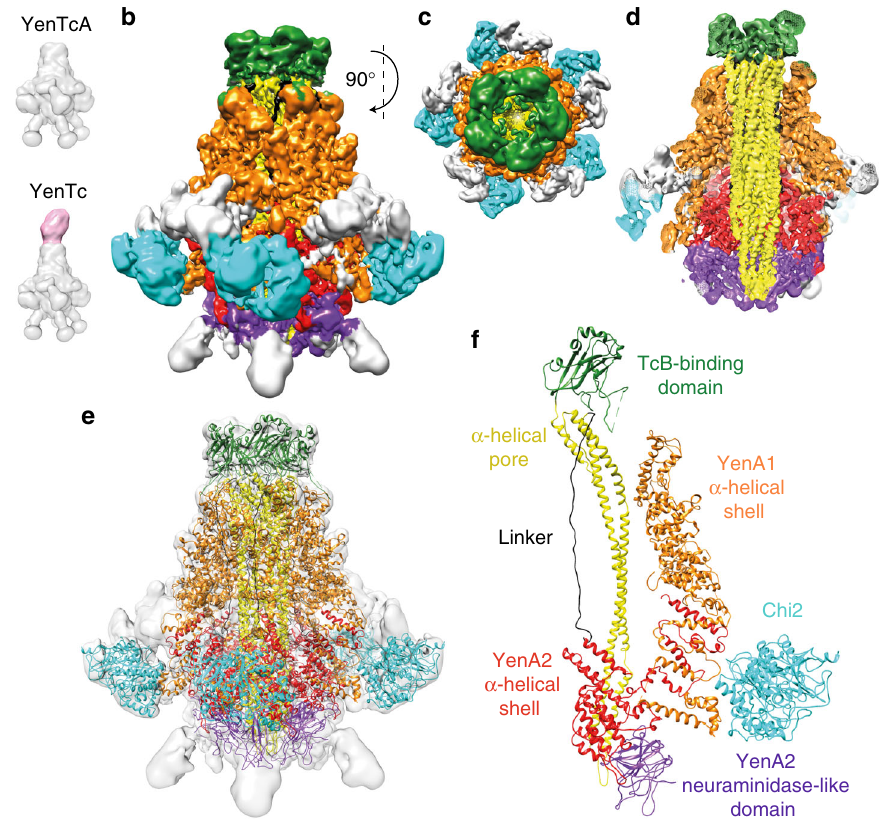
Fig. 1 The structure of YenTcA at 4.4 Å resolution. a Schematic representing the structure of YenTcA in the context of the holotoxin, YenTc. b , c 3D Cryo- EM map of the pentameric YenTcA in the soluble (pre-pore) conformation as side and top view orientations. d A cut-away view of the map revealing the encapsulated translocation pore. The map ( b – d ) is fi ltered according to local resolution and coloured according to the structural subdomains subsequently identi fi ed in the atomic model, which is displayed with the map transparently overlayed in e . A single protomer is shown in f . Colouring: YenA1 α -helical shell domain (orange); YenA2 TcB-binding domain (green), α -helical pore domain (yellow), linker (black), α -helical shell domain (red), neuraminidase-like domain (purple); Chi2 chitinase domain (cyan). Density corresponding to Chi1 is masked out in this map (refer to Fig. 2). Areas coloured grey correspond to regions of the map where it was not possible to build an atomic model due to structural ambiguity and/or the low local resolution of the map in these